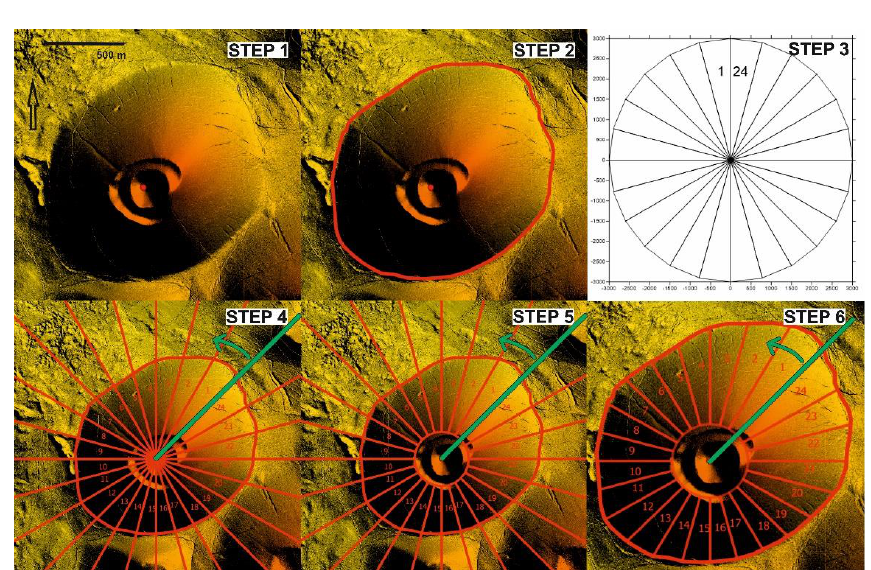
Figure 3. Example of the sectorization steps described in the text. The green line (Steps 4–6) indicates the selected primary direction and the whole setting is rotated to the 12 o’clock position indicated by the green arrow (LiDAR DTM with shaded topography).